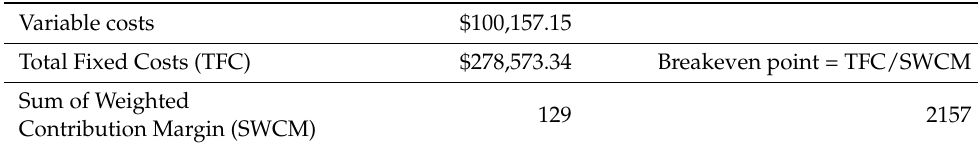
Table 13. Breakeven point in packages.